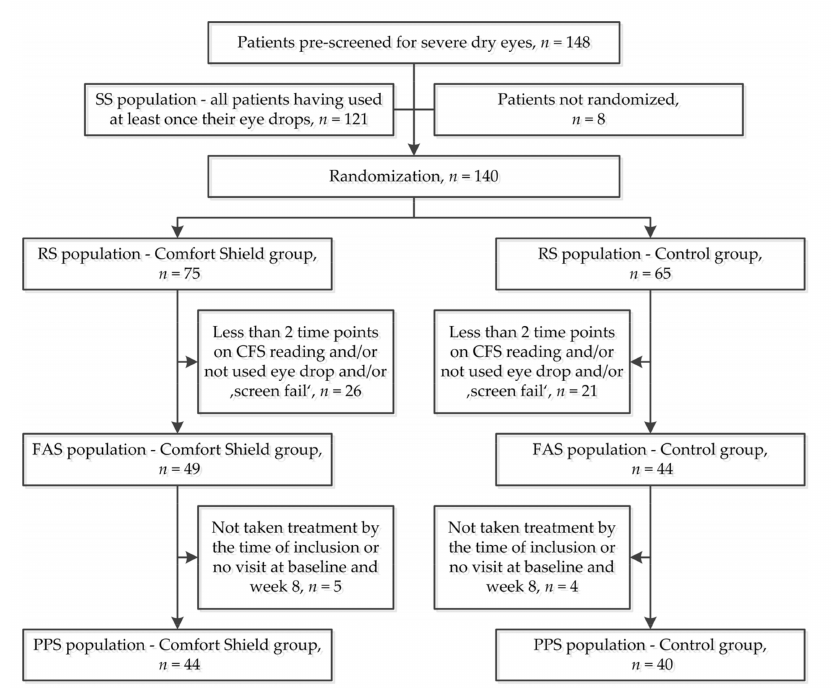
Figure 1. Participant